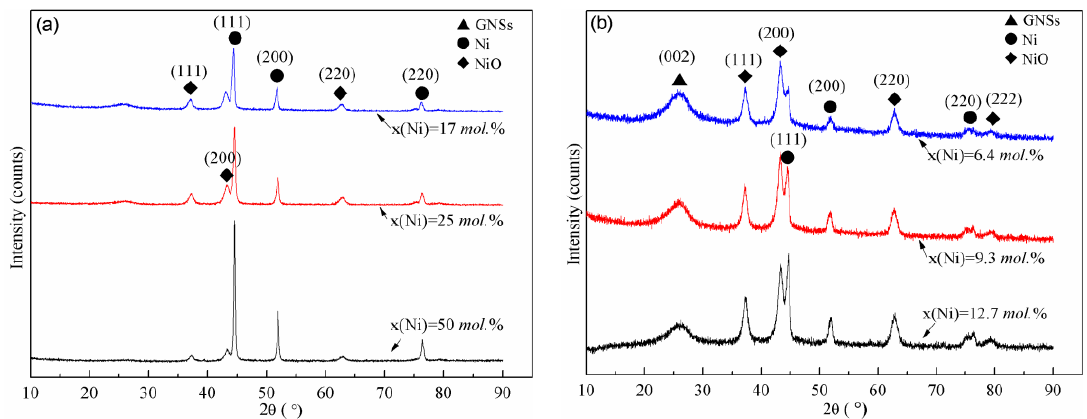
Figure 6. XRD patterns of the Ni-GNSs with various theoretical Ni loadings ( a ) 17–50 mol % and ( b ) 6.4–12.7 mol %.